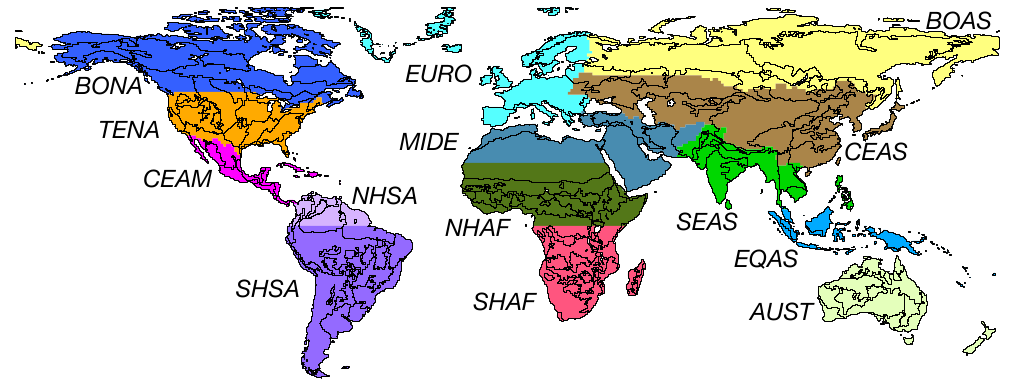
Figure 1. Regions used for analysis (outlines) overlaid on GFED regions (colors and labels; Giglio et al., 2006). See Table 1 for abbreviations. Shapefile with analysis regions available in the